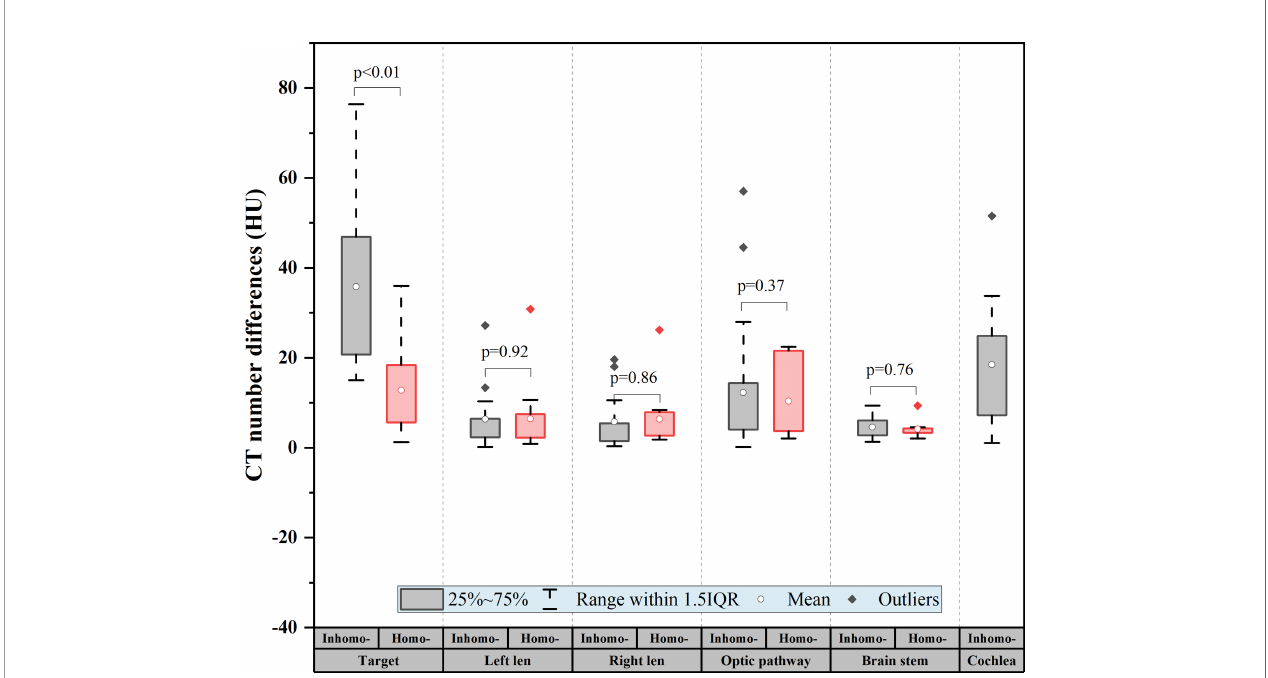
FIGURE 1 | CT number difference of the target and organs at risk (OARs) for all patients. The difference = |(post-CA) − (pre-CA)|. The deviation value of the target was the largest at approximately 37 HU (inhomo-) and 13 HU (homo-) ( P < 0.01), and the values of the OARs were not statistically signi fi cant ( P -value > 0.05).